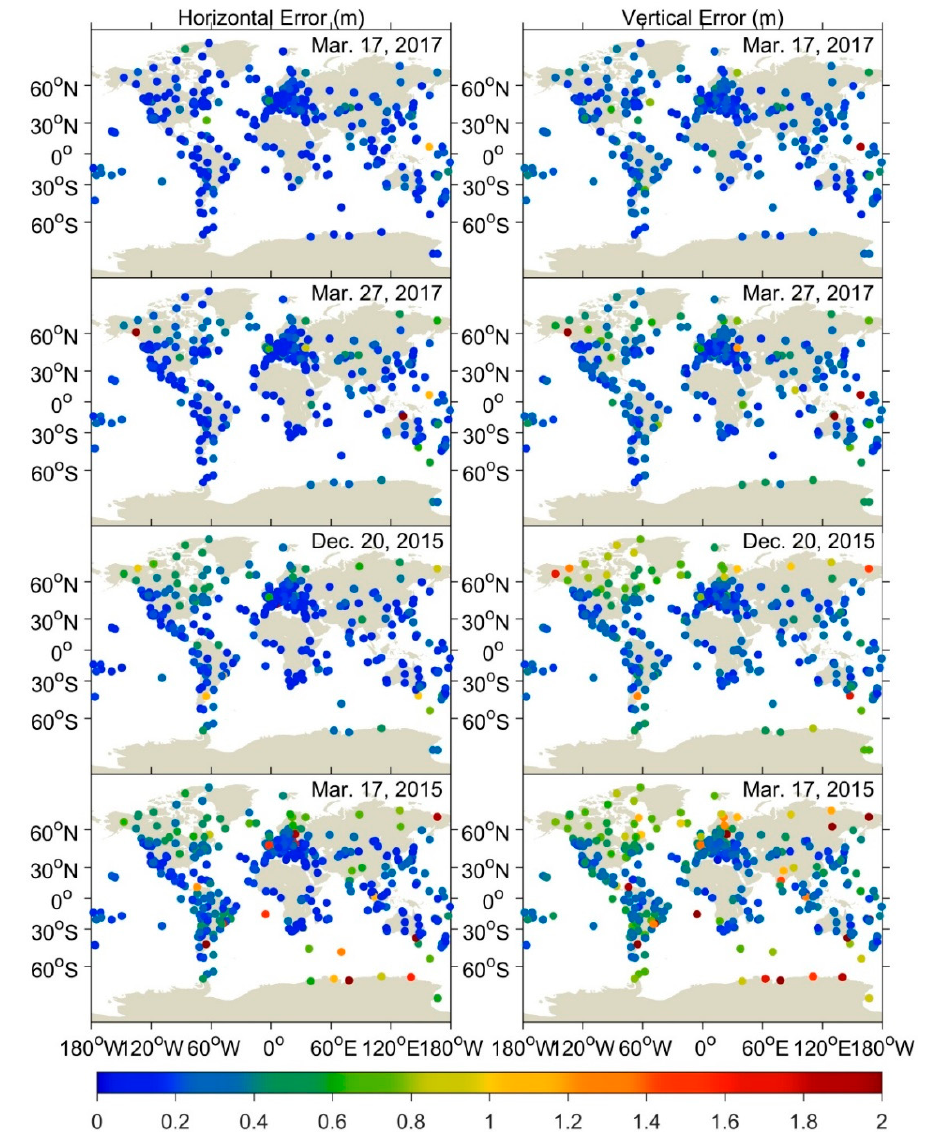
Figure 8. RMS statistics of SF PPP for worldwide GPS stations during the quiet, moderate, intense, and super storm period.